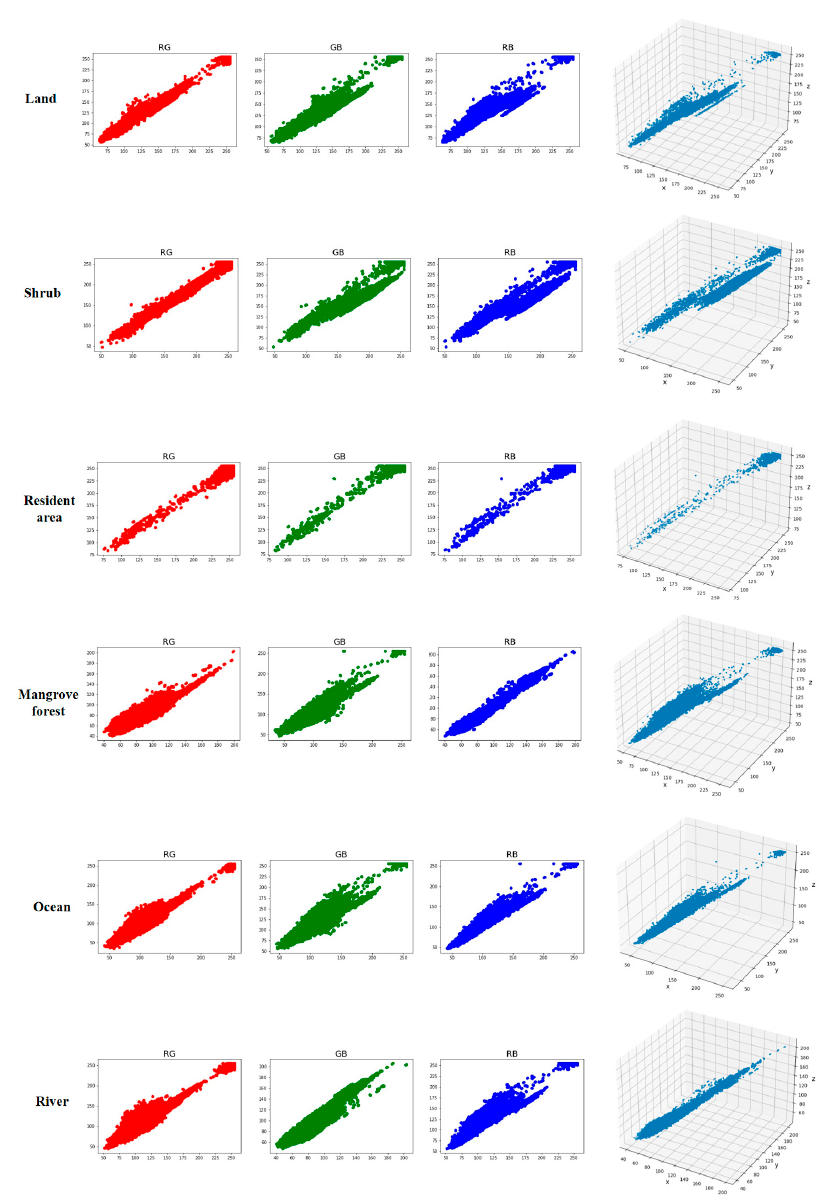
Figure 10. Distribution of color features.